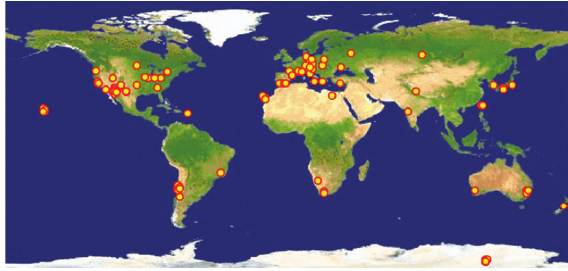
Figure 9: The robotic telescopes of the world, adapted from [46].